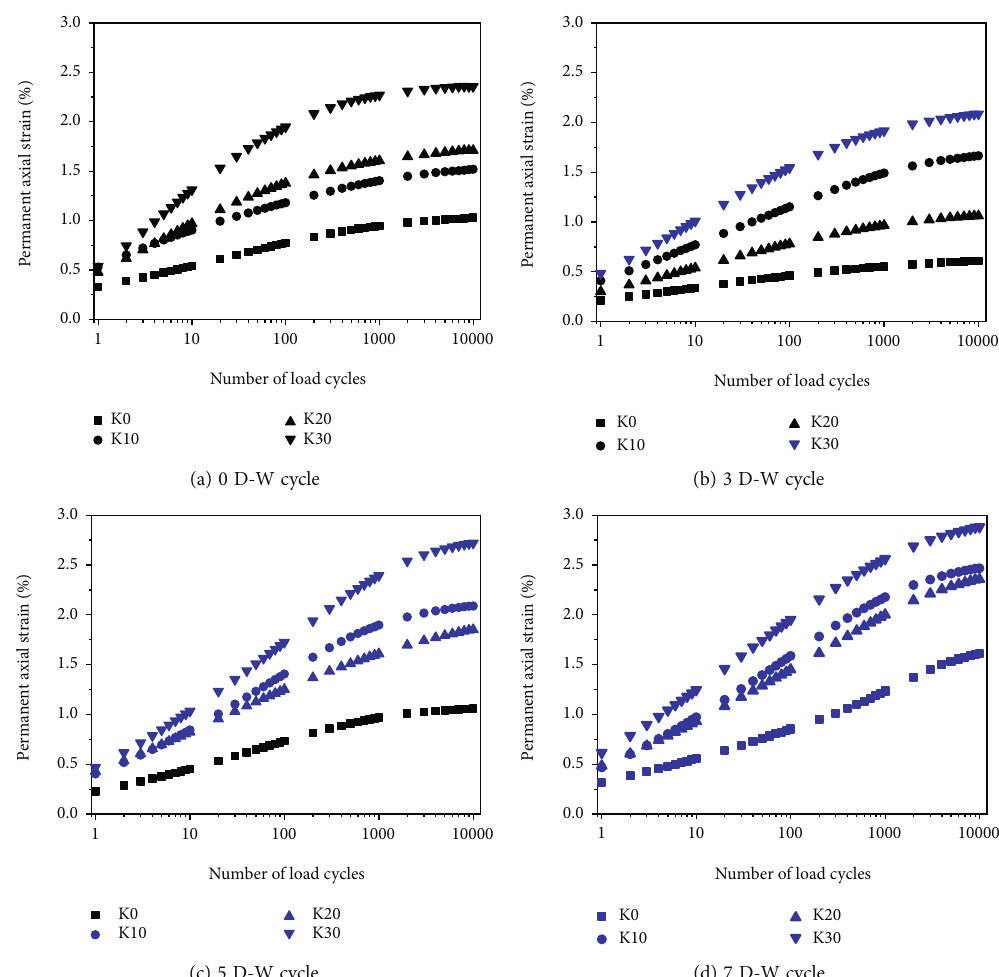
Figure 14: Permanent axial strain of GRS with di ff erent fi ne particle contents. (black point: plastic shakedown; blue point: plastic creep).